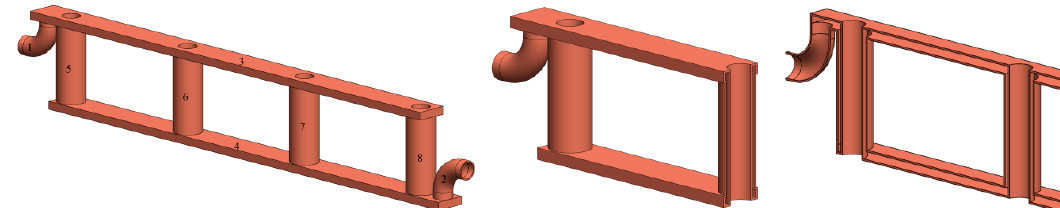
Figure 5. The basic variant of the manifold header in isometric view ( left ), cross-section view ( right ), and longitudinal-section view ( middle ); 1—inlet pipe, 2—outlet pipe, 3—distribution channel, 4—collection channel, and 5 to 8—heat exchange chambers with inner heat pipe head housing pipe and outer chamber wall.